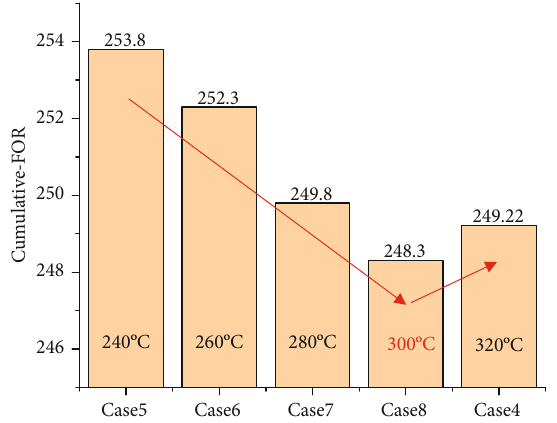
Figure 30: The cumulative FOR in di ff erent cases. Table 7: Optimization of the superheated degree.